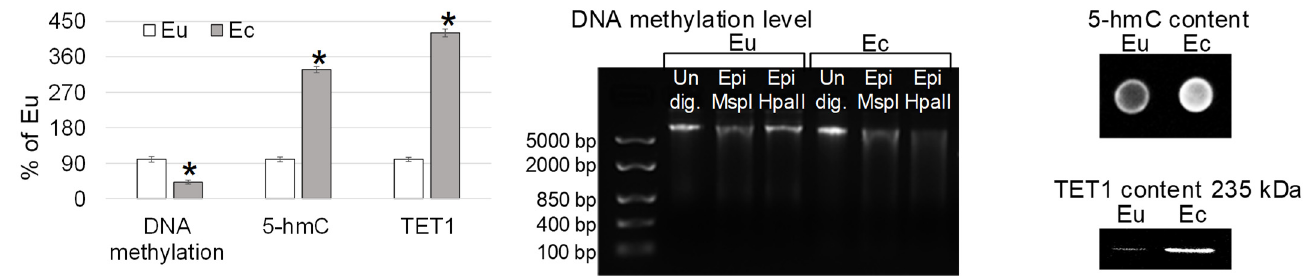
Figure 4. The epigenetic events in the eutopic and ectopic endometrium: total DNA methylation level, the relative content of 5-hmC and active demethylase TET1 (tet methylcytosine dioxygenase 1) with typical pictures. Eu—eutopic endometrium. Ec—ectopic endometrium. Undig.—undigested DNA. Epi MspI—digested with Epi MspI. Epi HpaII—digested with Epi HpaII. Western-blotting and restriction analysis were performed twice, dot-blotting—thrice. *— p < 0.05 in comparison with norm Eu.